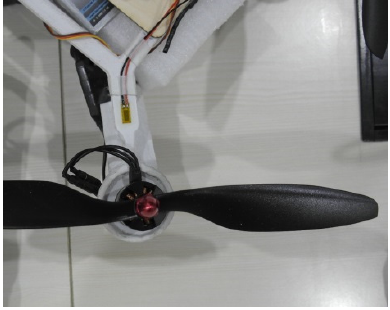
Figure 19. Monocoque Quadcopter structure with strain gauge.